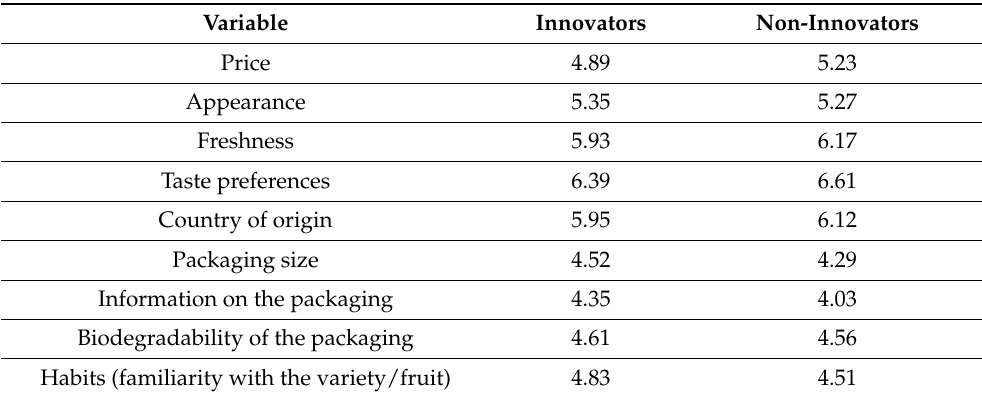
Table A3. Significance * of selected features of fruits and fruit preserves for innovators and non-